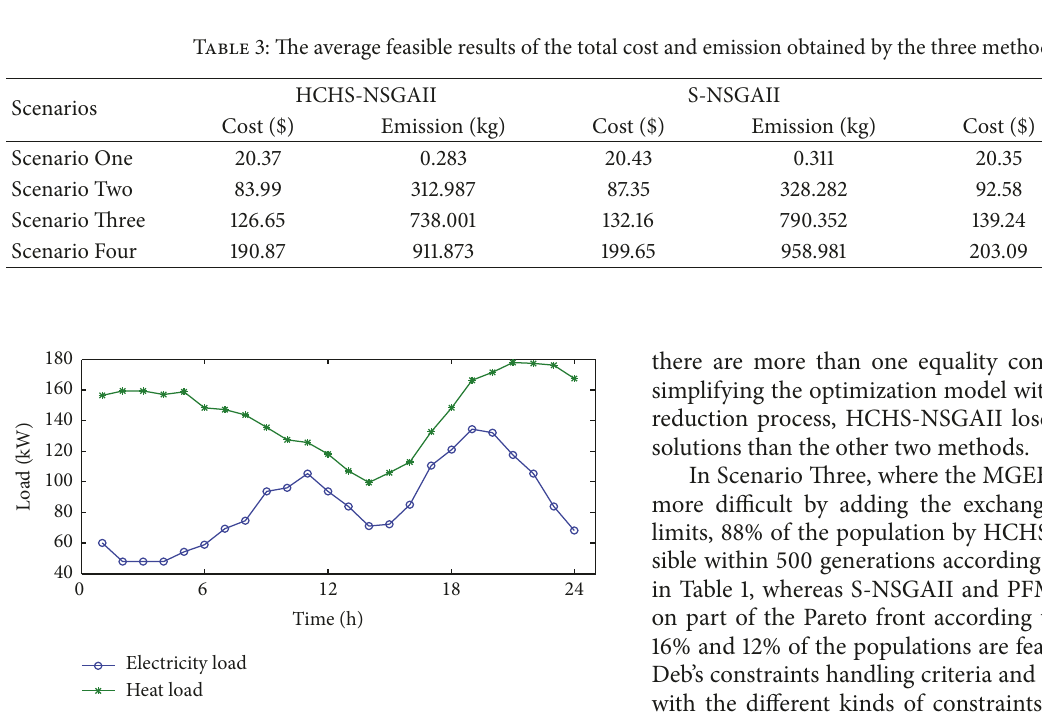
Figure 3: The heat load and electricity load